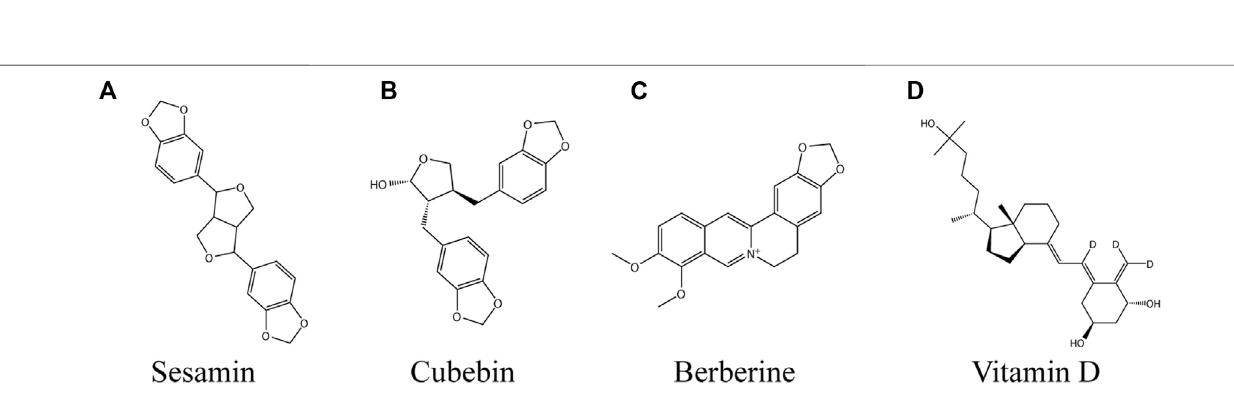
Frontiers in Pharmacology |